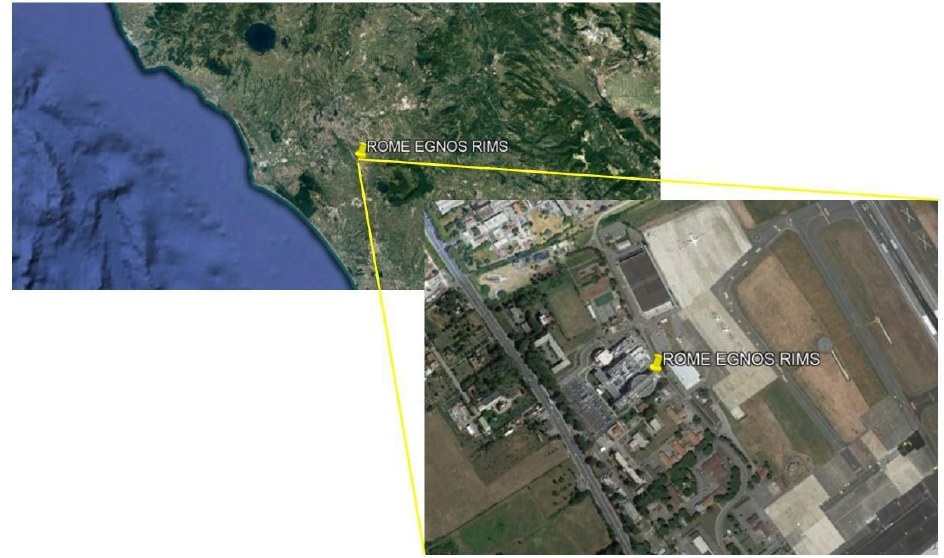
Figure 2. EGNOS RIMS located in the airport of Rome “Ciampino”.